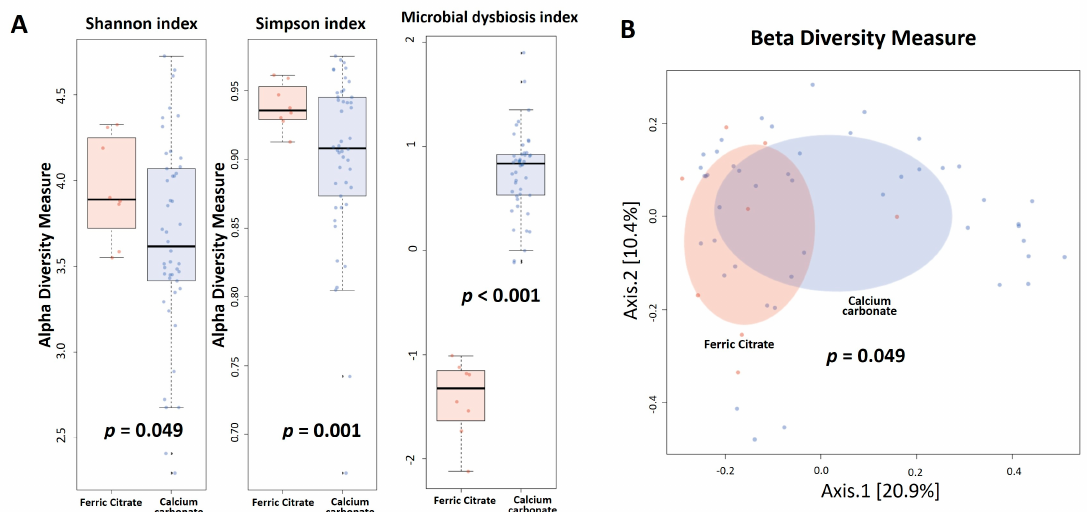
Figure 1. Hemodialysis patients with calcium carbonate phosphate binders had lower α diversity (Shannon index and Simpson index), higher microbial dysbiosis index ( A ), and different β diversity (Bray-Curtis distance metrics) ( B ) compared to the ferric citrate phosphate binders used.